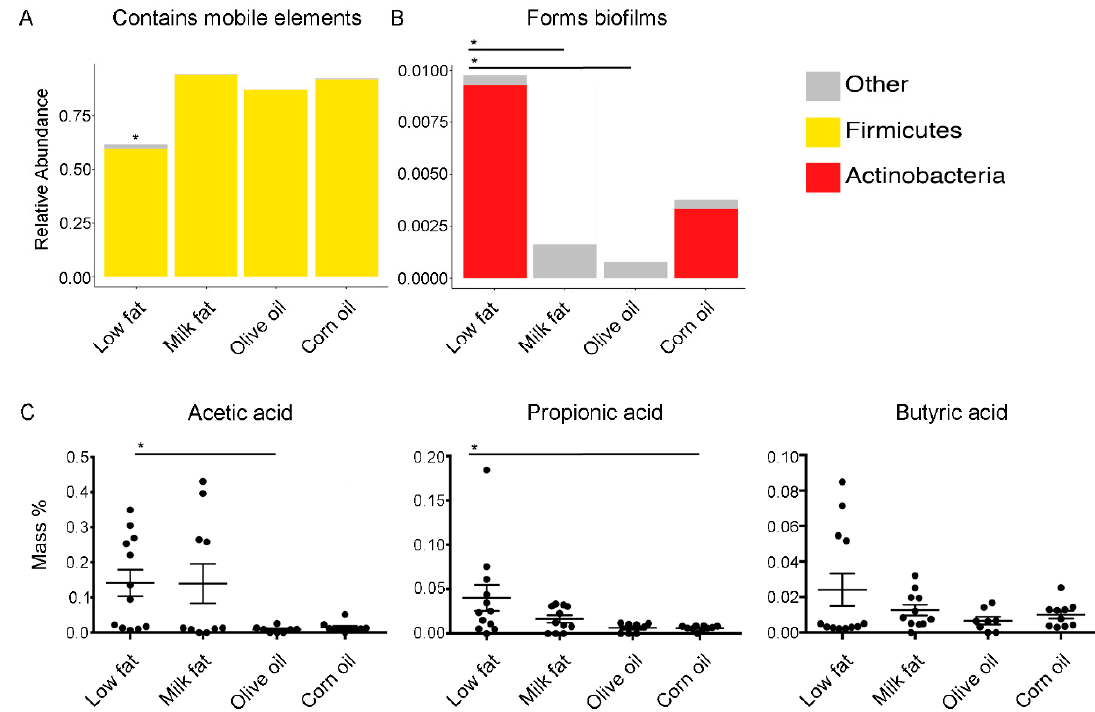
Figure 3. The effect of lipid diets on predicted microbial functions. Statistically and biologically differentially abundant pathways amongst the four dietary group shown as a histogram of the LDA scores. The length of the bars represents a log10 transformed LDA score set to a threshold value of 2. The one-to-all version of LEfSe was used with Kruskal–Wallis test ( P < 0.05).